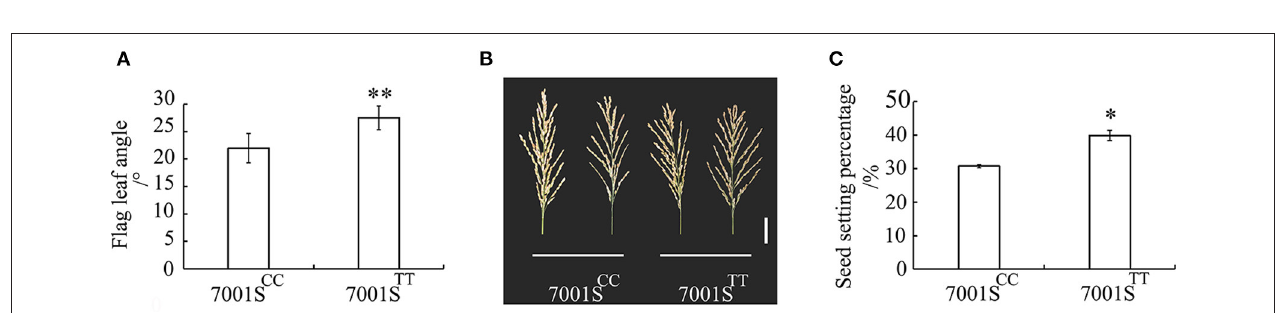
FIGURE 5 | Evaluation of the utilization value for OsFLA2 alleles. (A) Comparison of the FLA of 7001S FLA 2 − CC and 7001S FLA 2 − TT . Data represent means ± SD ( n = 40 independent plants). ** P < 0.01, Student’s t -test. (B) Panicle morphology of 7001S FLA 2 − CC and 7001S FLA 2 − TT . Scale bar, 5cm. (C) Comparison of the seed